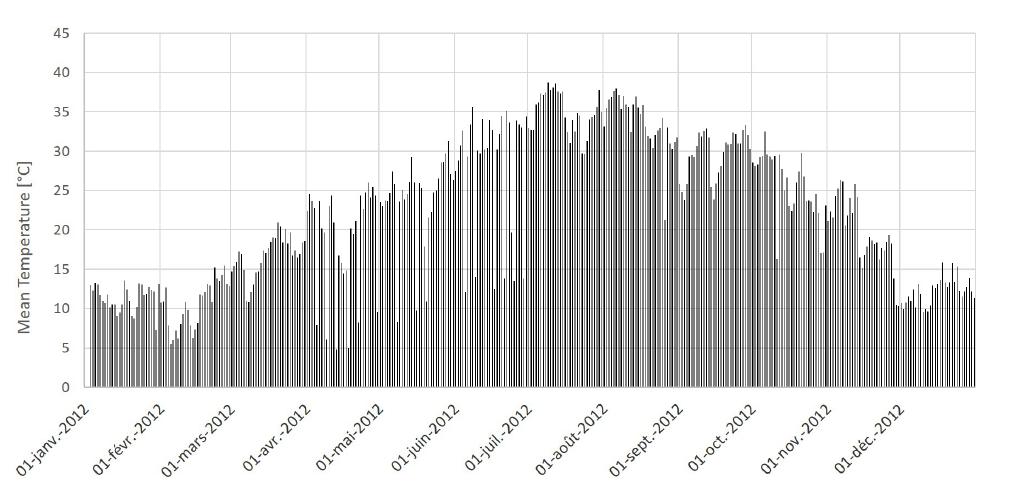
Figure 4. Daily mean temperature (in ◦ C) in Tozeur during